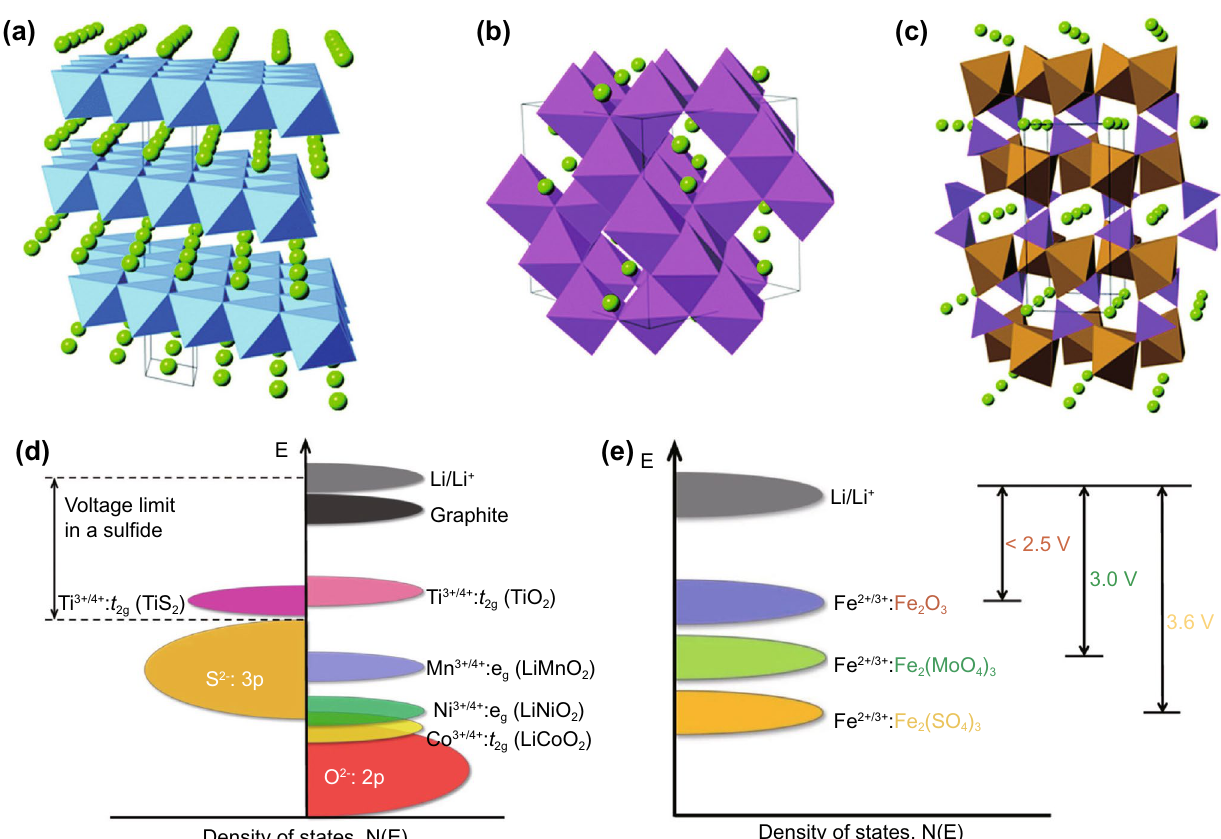
Fig. 3 Schematics of the common LIB cathodes, a layered LiCoO 2 , b spinel LiMn 2 O 4 and c olivine LiFePO 4 , with green atoms representing lithium [34] . Creative Commons License (CC BY 3.0). d Relative positions of the energy bands of different elements in LIB, showing the higher stability of Mn and Ni with oxygen compared to Co. e Illustration of the inductive effect of polyanions in increasing the cell voltage relative to lithium metal [16]. Creative Commons License (CC BY